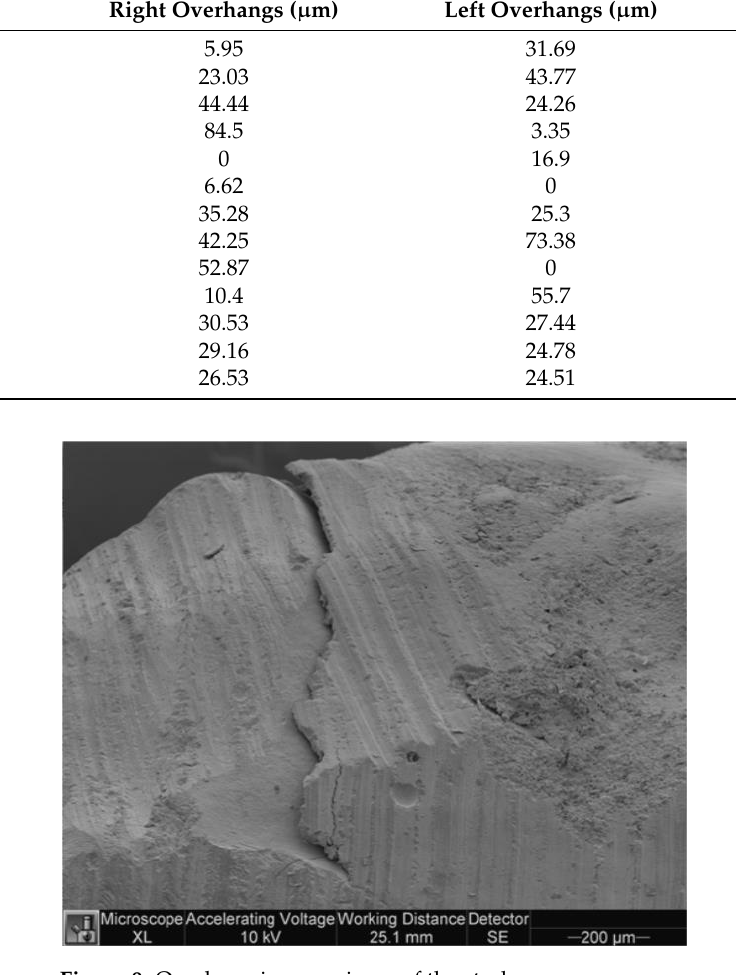
Figure 9. Overhang in a specimen of the study group.